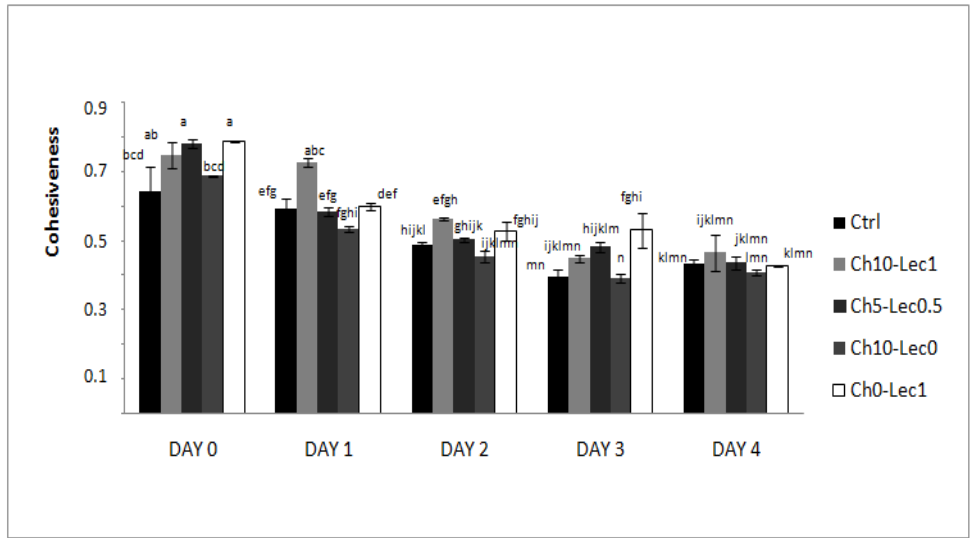
ff erent formulations during storage at 25 ◦ Figure A2. Crumb Cohesiveness of the different formulations during storage at 25 °C. Figure A2. Crumb Cohesiveness of the di